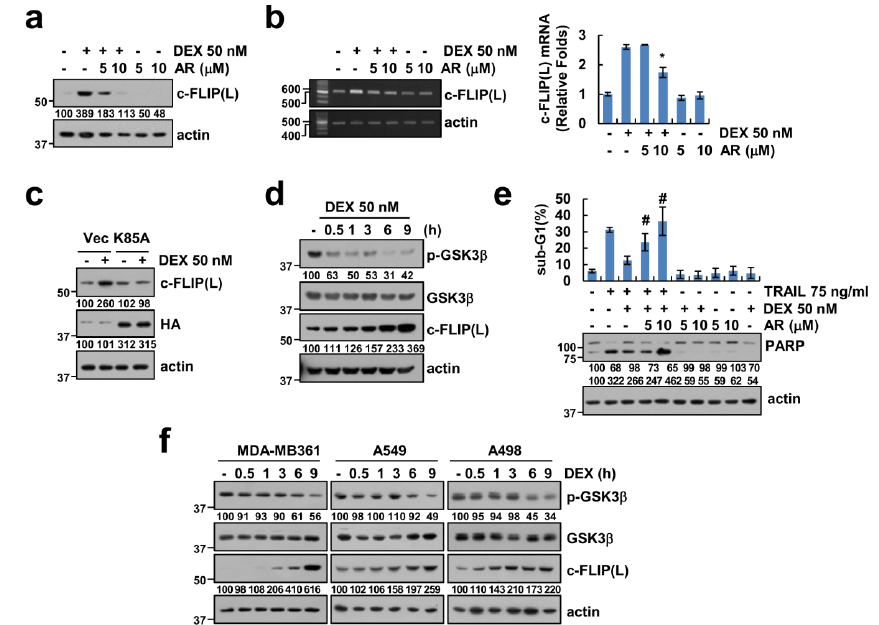
Figure 4. GSK-3 β plays a critical role in DEX-induced c-FLIP upregulation. ( a , b ) Caki-1 cells were Figure 4. GSK-3β plays a critical role in DEX-induced c-FLIP upregulation. (a,b) Caki-1 cells were pretreated with a GSK-3 β inhibitor (AR-A014418) for 1 h, and then treated with 50 nM DEX for 24 h. pretreated with a GSK-3β inhibitor (AR-A014418) for 1 h, and then treated with 50 nM DEX for 24 h. ( c , d ) Caki-1 cells were treated with 50 nM DEX for 24 h ( c ) or the indicated time periods ( d ). ( e ) Caki-1 (c,d) Caki-1 cells were treated with 50 nM DEX for 24 h (c) or the indicated time periods (d) . (e) Caki- 1 cells were pretreated with a GSK-3β inhibitor (AR-A014418) for 1 h, and then added with 75 ng/mL cells were pretreated with a GSK-3 β inhibitor (AR-A014418) for 1 h, and then added with 75 ng / mL TRAIL in the presence or absence of 50 nM DEX. (f) Cells were treated with 50 nM DEX for the TRAIL in the presence or absence of 50 nM DEX. ( f ) Cells were treated with 50 nM DEX for the indicated indicated time periods. Apoptosis, protein, and mRNA expression were determined by flow time periods. Apoptosis, protein, and mRNA expression were determined by flow cytometry ( e ), cytometry (e) , W estern blotting (a,c–f) , PCR, and qPCR (b) , respectively. Values in the graphs (b,e) Western blotting ( a , c – f ), PCR, and qPCR ( b ), respectively. Values in the graphs ( b , e ) represent mean ± represent mean ± SD of three independent experiments. * p < 0.01 compared to DEX. # p < 0.01 SD of three independent experiments. * p < 0.01 compared to DEX. # p < 0.01 compared to TRAIL + compared to TRAIL + DEX. Uncropped pictures of the western blot shown in the Supplementary DEX. Uncropped pictures of the western blot shown in the Supplementary Figure Figure 6.